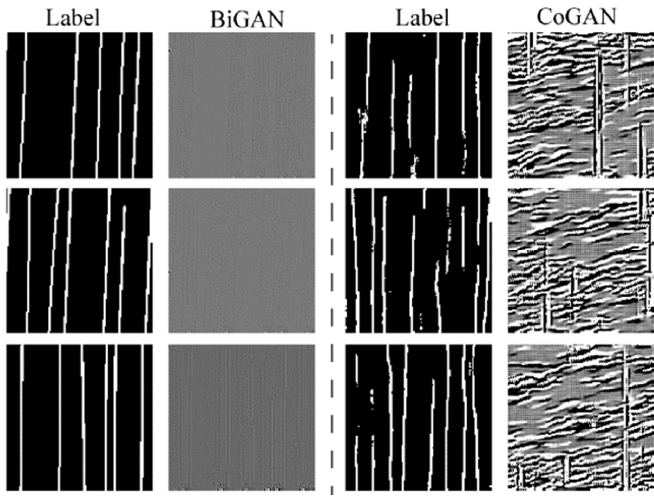
Figure 11. The generated samples of BiGAN (column 2) and CoGAN (column 4).